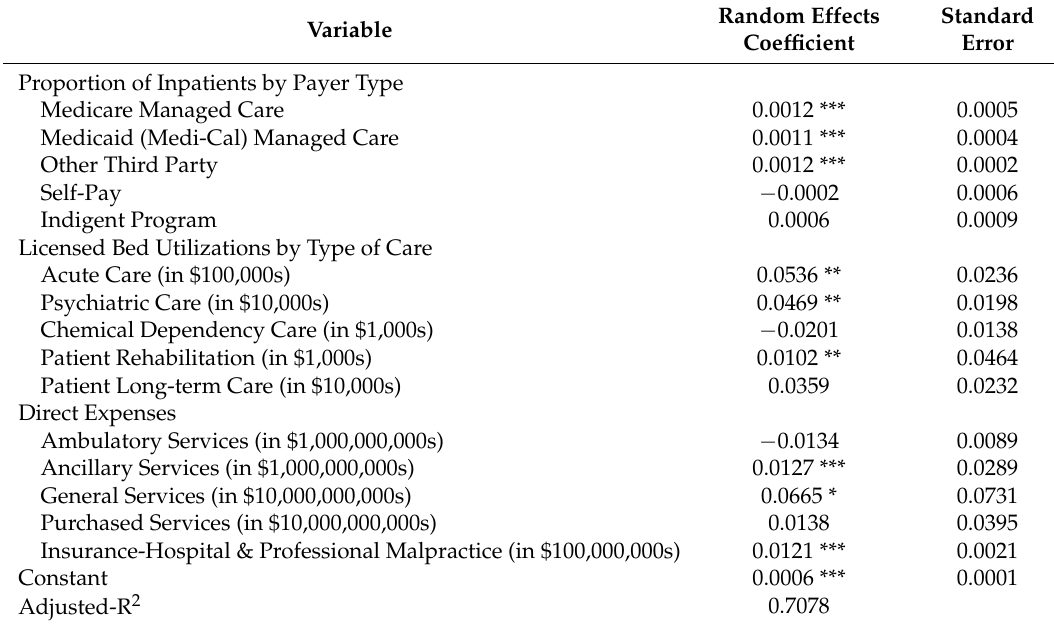
Table 9. Relative Market Share Equation of For-profit